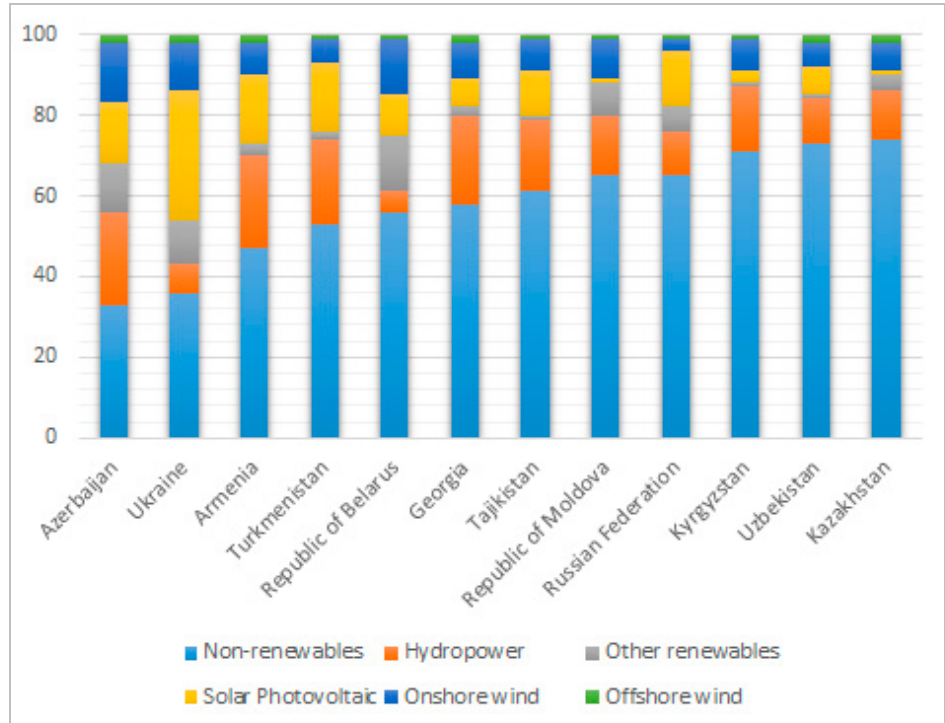
Figure 2. Share of RES in power generation in EECCA countries according to PES in 2050. Source: compiled by the authors.